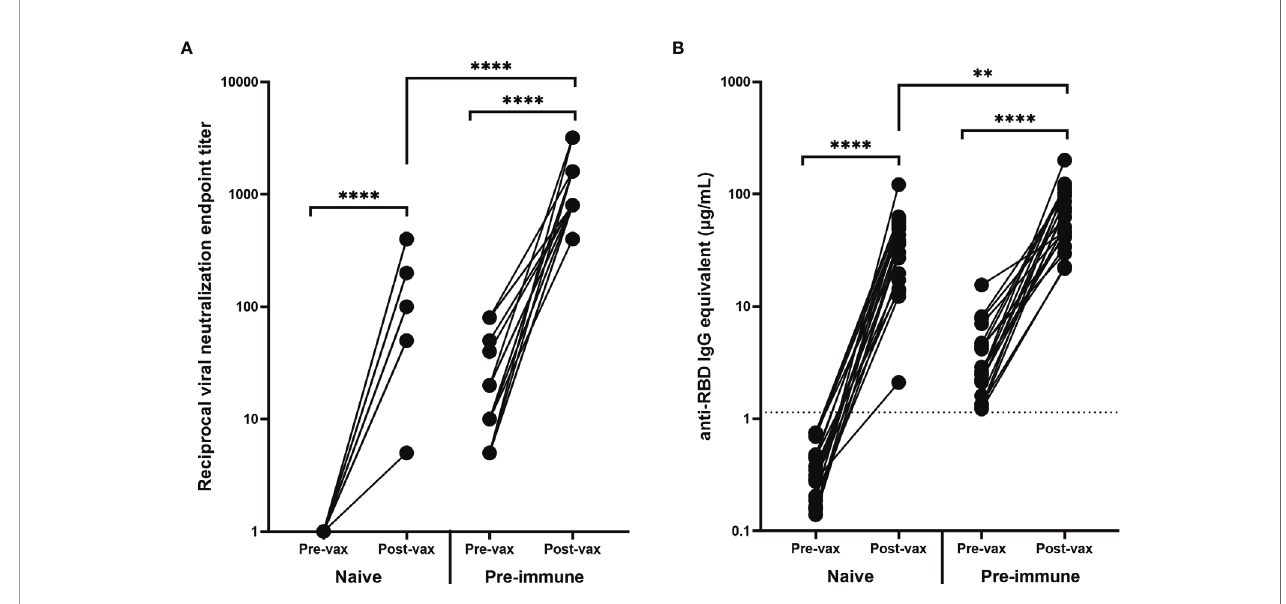
FIGURE 3 | Antibody response before and after vaccination. Vaccination signi fi cantly increased the (A) VN and (B) RBD-binding antibody levels of all participants regardless of pre-vaccination naïve (n = 20) or pre-immune (n = 20) status (**** p < 0.0001). The post-vaccination VN and anti-RBD IgG levels for participants who were pre-immune prior to vaccination were signi fi cantly higher (**** p < 0.0001 and ** p < 0.01 respectively). Post-vaccination timepoints took place a minimum of 14 days after the administration of the second mRNA vaccination. In order to represent the values on a logarithmic scale, lack of neutralization was reported as